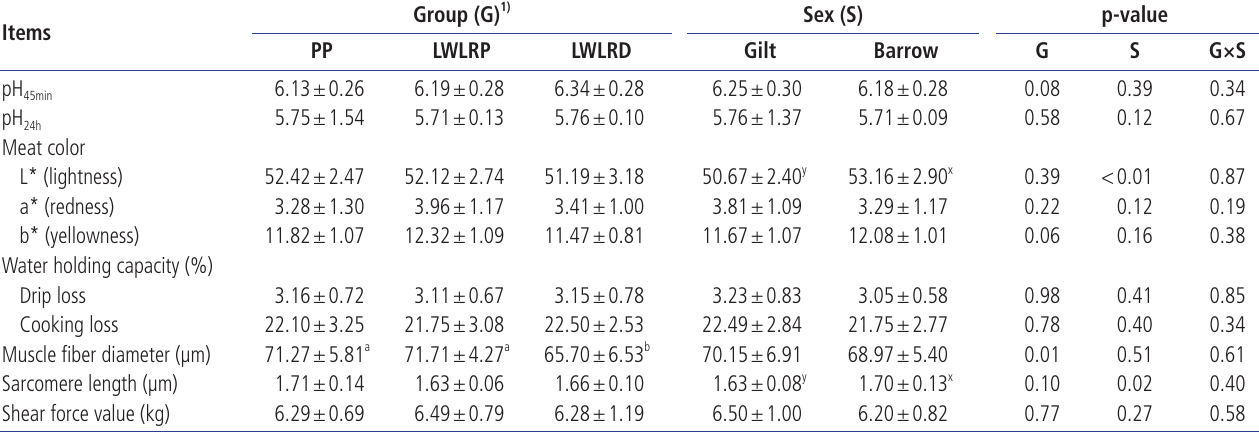
Table 3. Means±standard deviation of meat quality parameters of Longissimus muscle from finished Pakchong 5 pig and crossbred pigs sired by Pakchong 5 or Duroc boar Items